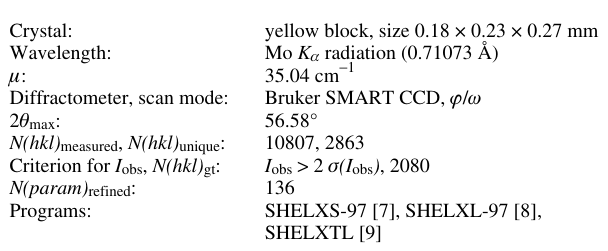
Table 1. Data collection and handling.